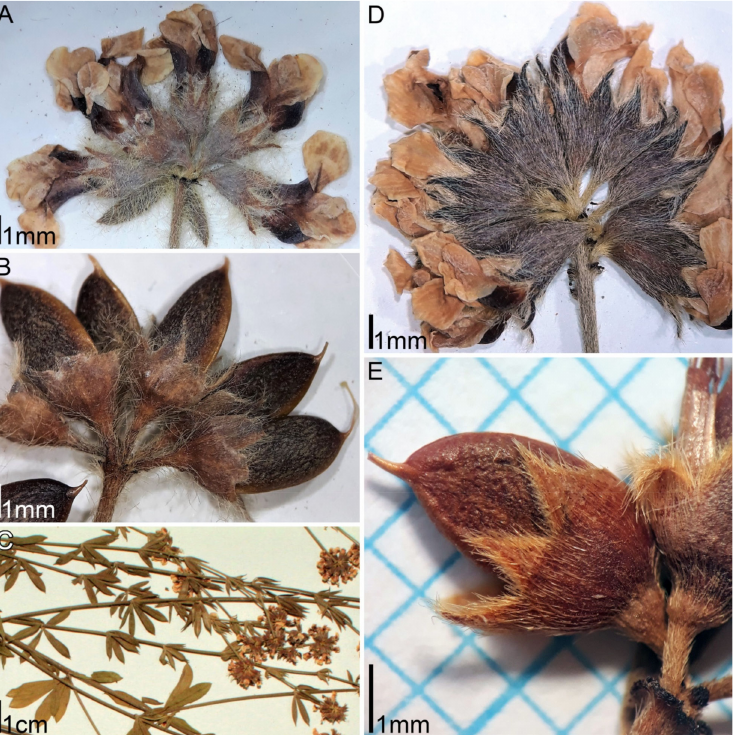
Figure 5. Morphology of Lotus dorycnium ssp. anatolicus ( A , B ) and ssp. haussknechtii ( C – E ): ( A ) umbel at anthesis (herbarium specimen: Turkey, M. Vural 967, GAZI); ( B ) fruits (herbarium specimen: Turkey, C. Birden 1421, GAZI); ( C ) fragments of flowering shoots (herbarium specimen: Turkey, H. Duman & F. Karavelio˘gulları 2232, GAZI); ( D ) umbel at anthesis (herbarium specimen: Turkey, A. Duran 2627, GAZI); ( E ) fruit (herbarium specimen: Turkey, Byfield & Pearman 73323, ISTE).